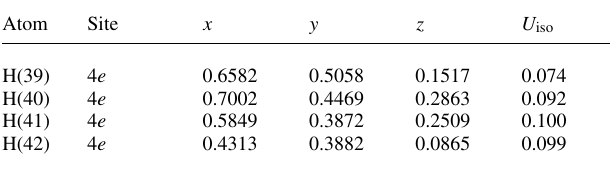
Table 2. Atomic coordinates and displacement parameters (in Å 2 )